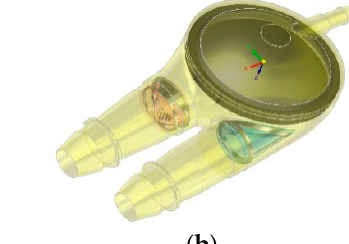
Figure 6. ReligaHeart EXT heart assist pump with new valves ( a ) view from the side of the blood chamber, ( b ) view from the pneumatic chamber.